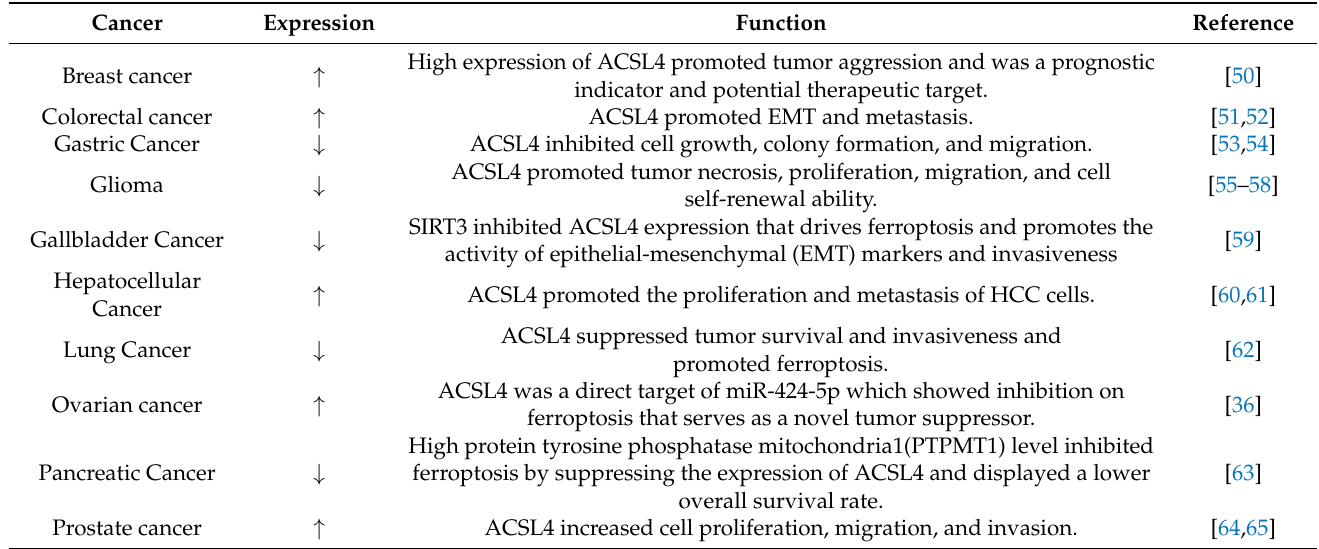
Table 2. ACSL4 in